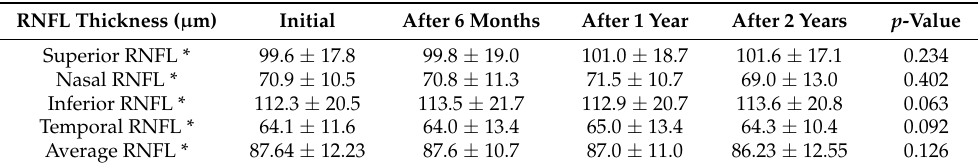
Table 1. Mean values of RNFL thickness in group of patients that received multiple anti-VEGF intravitreal injections during a two-year follow-up.